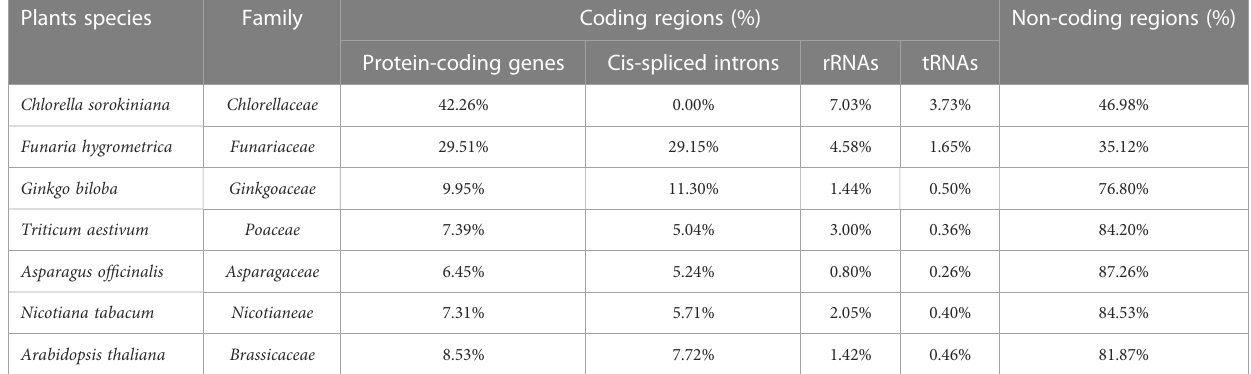
TABLE 5 Comparison of genome characteristics in seven plant mitochondrial